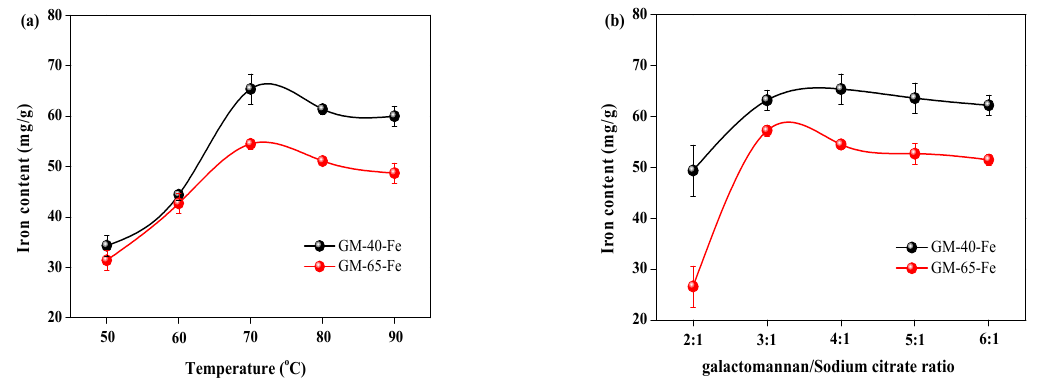
Figure 2. Complex synthesis around the variable temperature ( a ) and galactomannan/sodium citrate ratio ( b ) with respect to iron